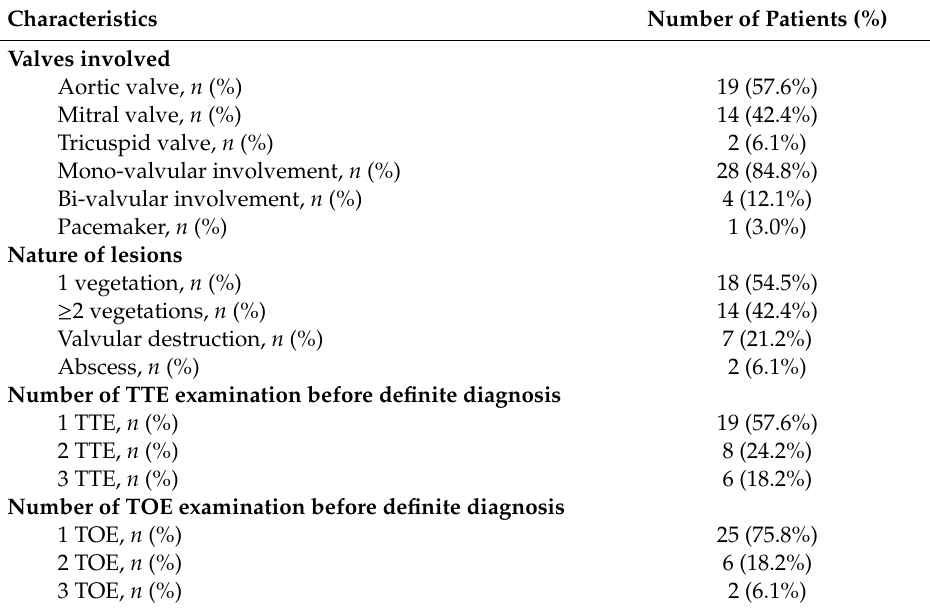
Table 4. Echocardiographic